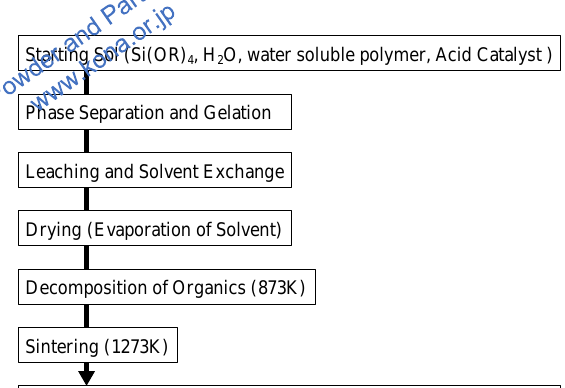
Fig. 10 Synthesis of porous glass by chemical phase separation (modified from Nakanishi